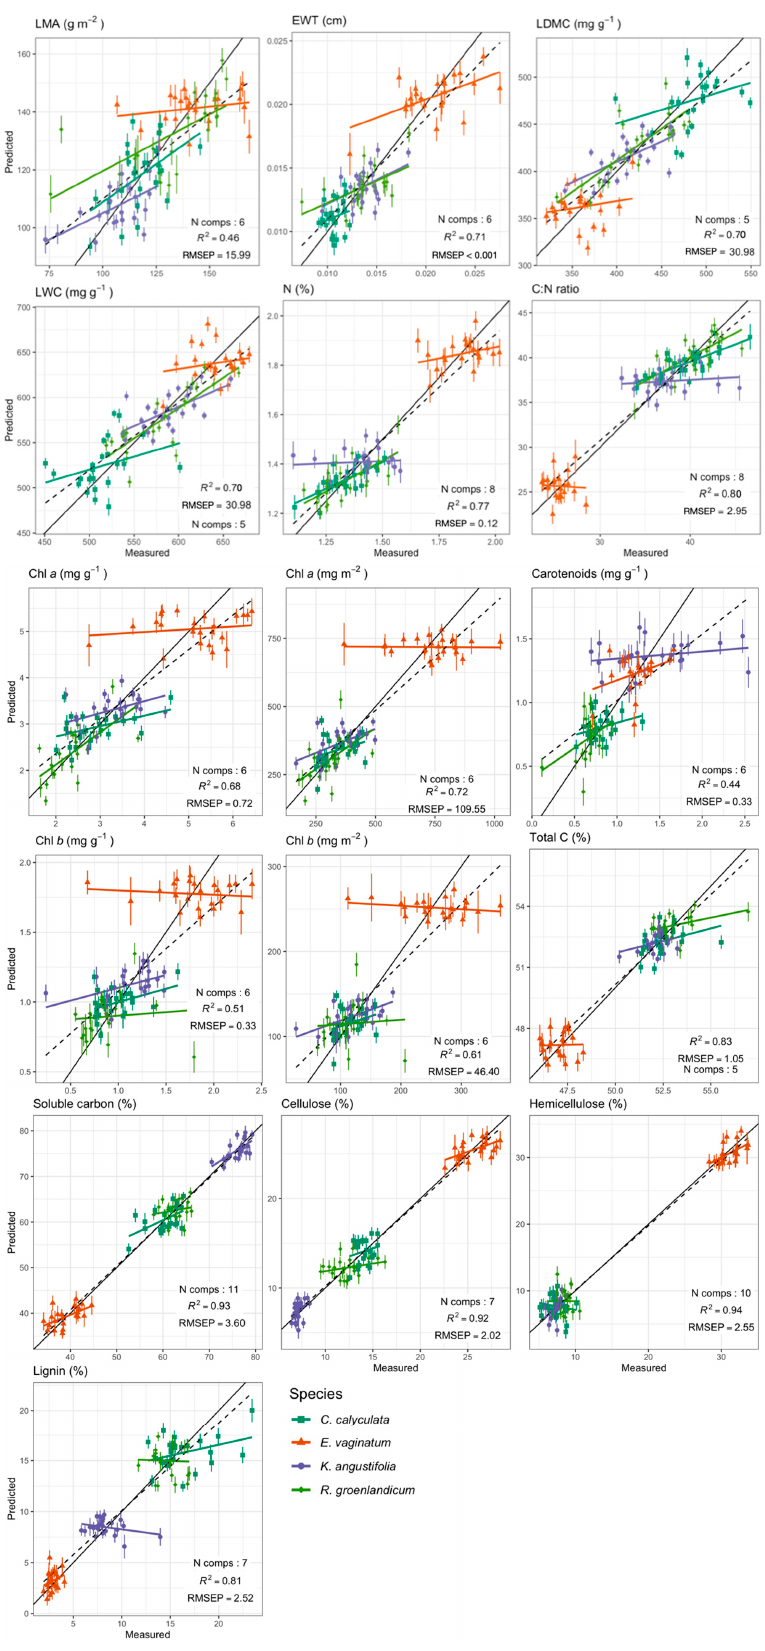
Figure 5. Relationships between predicted and measured leaf chemical and structural properties using leaf-level spectral data. Solid line indicates a 1:1 relationship, black dashed lines are the linear relationship between predicted and measured values for all species combined, colored solid lines are the linear relationship between predicted and measured values per species. Error bars indicate the mean SD of PLSR predictions based on 100 iterations. N comps is the number of components per model. RMSEP is the mean root mean square error of prediction in original units.